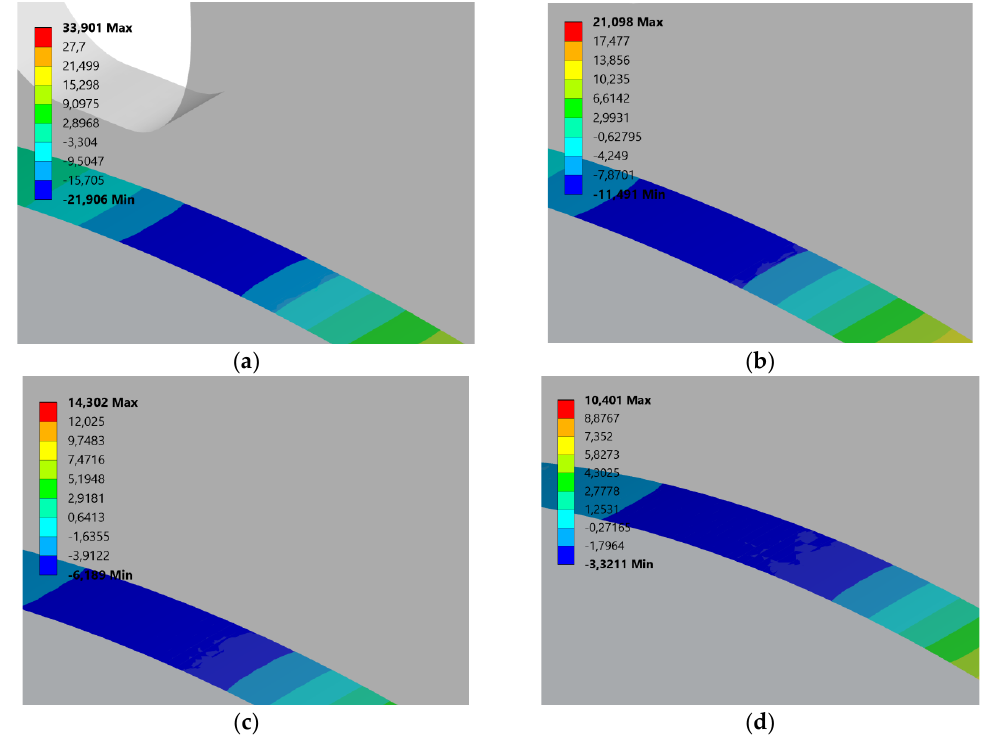
Figure 12. Normal stress results for hybrid gears generated rack tip radius, ρ 1 = 0.2 xm for different